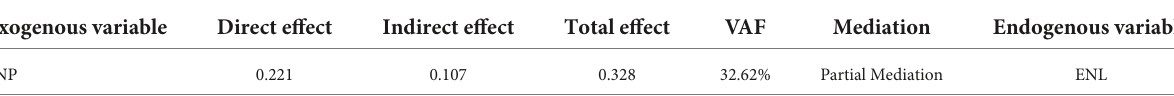
TABLE 8 Mediation